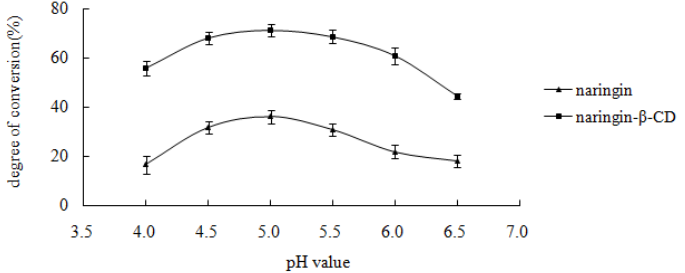
Figure 3. Effect of pH value of acetate buffer. Reaction was performed by adding 10 mg substrate, 10 mg snailase, and 1 mL glacial acetic acid and sodium acetate anhydrous buffer (pH 4.0, 4.5, 5.0, 5.5, 6.0, and 6.5) at 37 °C for 24 h. Each point represents the mean ± SD ( n = 3).